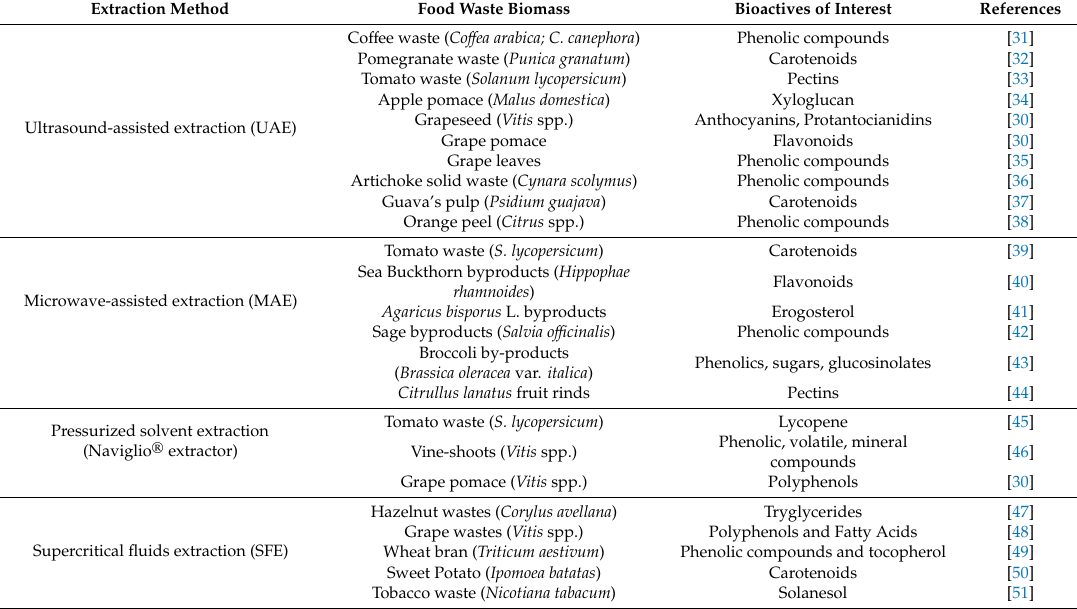
Table 3. Examples of target phytochemicals from fruit and vegetable